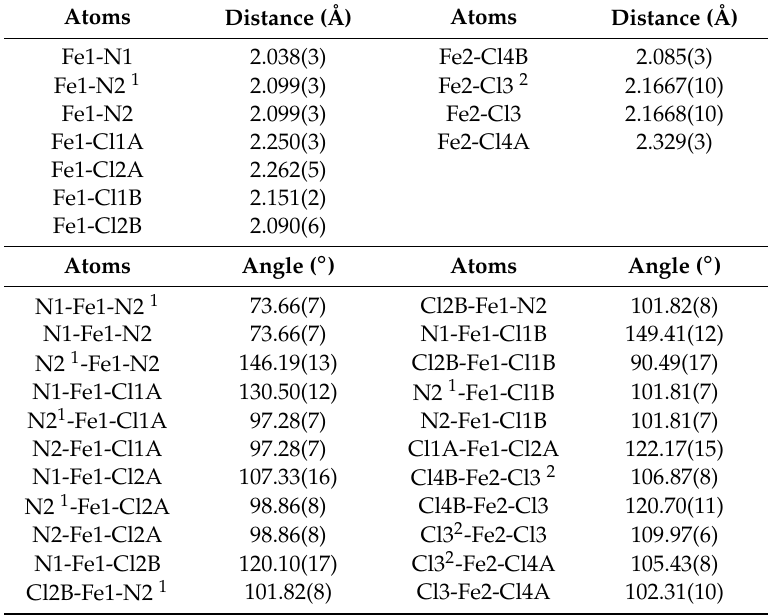
Table 4. Bond distances and angles in 2